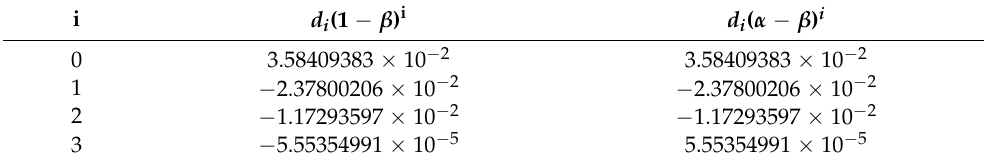
Table 3. Numerical values of d i (1 − β ) i and d i ( α − β ) i